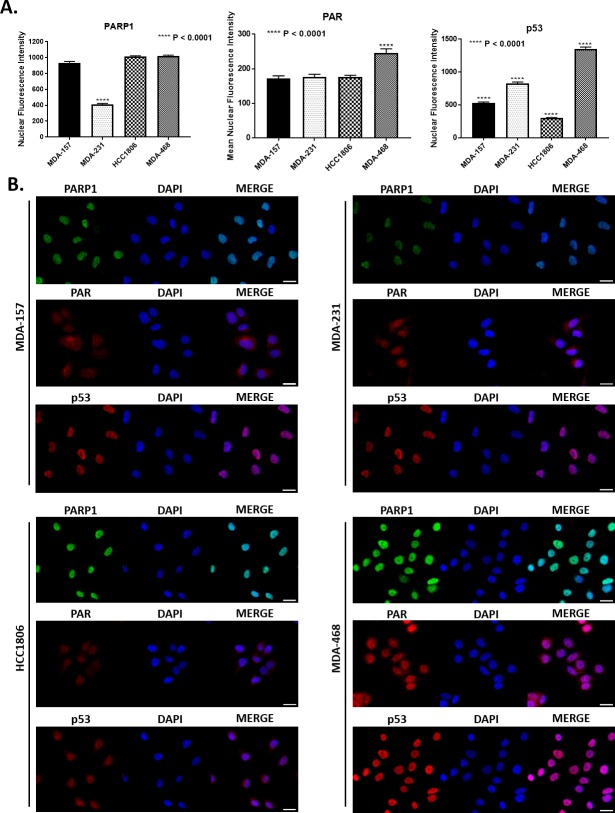
Nuclear intensity of key BER proteins.A) Quantification of mean nuclear fluorescence intensity is shown for PARP1 (**** P < 0.0001, MDA-231 to MDA-157, HCC1806, and MDA-468), PAR (**** P < 0.0001, MDA-468 to MDA-157, MDA-231, and HCC1806), and p53 (**** P < 0.0001, MDA-157 to MDA-231, MDA-157 to MDA-468, MDA-157 to HCC1806, MDA-231 to MDA-468, MDA-231 to HCC1806, and MDA-468 to HCC1806). B) Representative fluorescent images used for quantification in A for PARP1, PAR, and p53 for all cell lines tested. Scale bar = 20 μm.